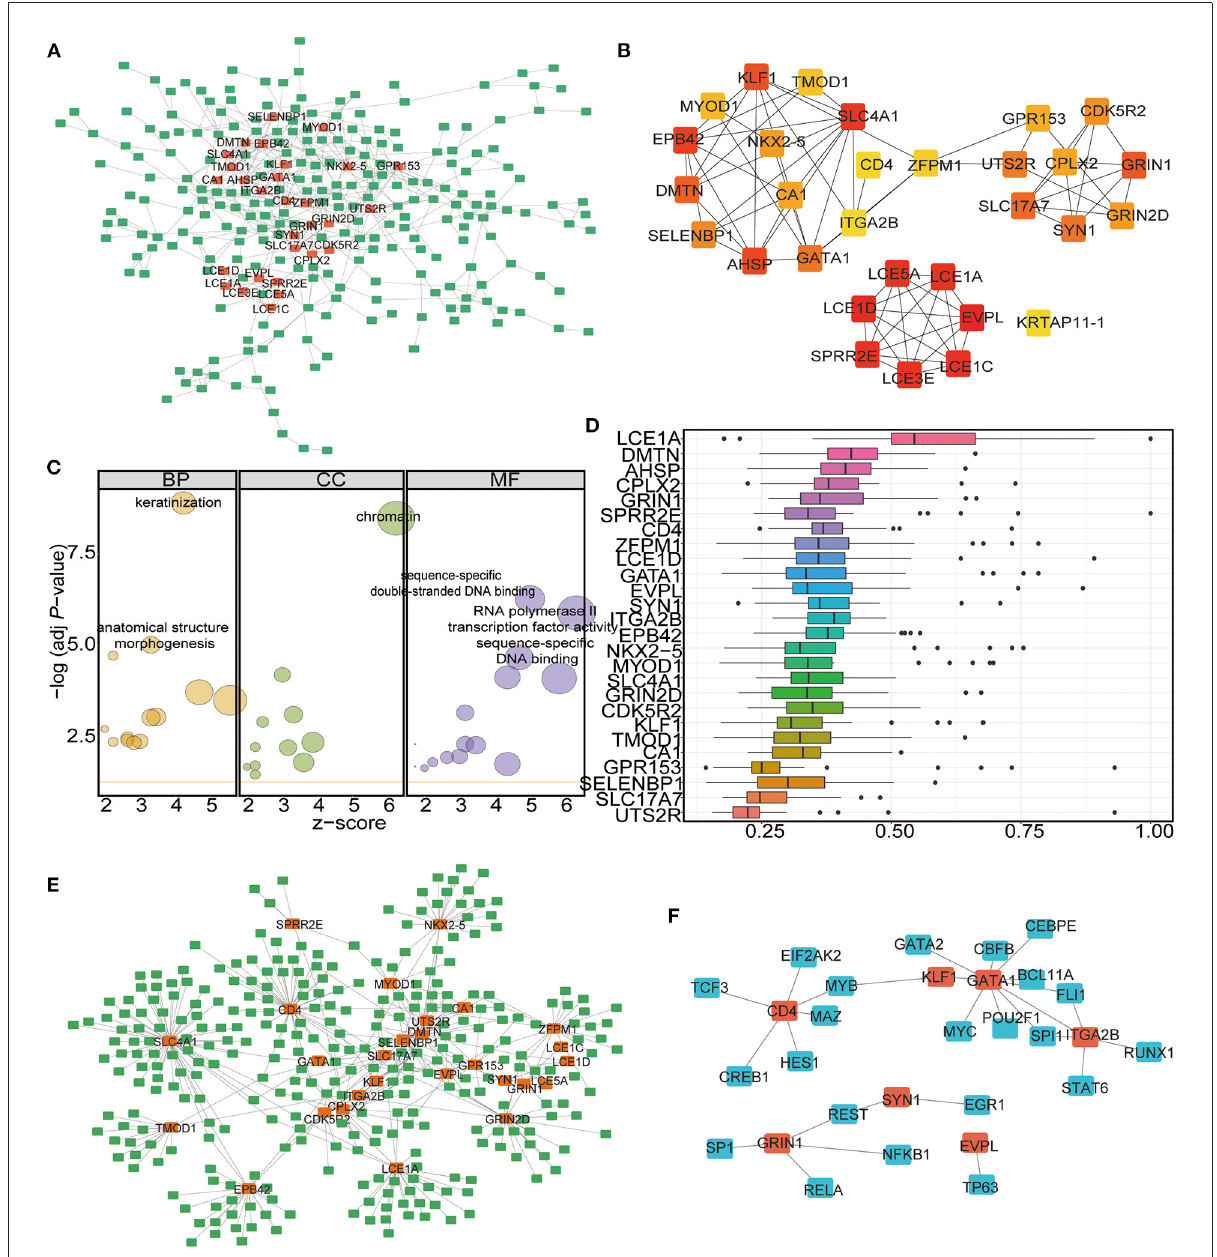
FIGURE7 Identification of the hub-genes and the miRNA-mRNA-TF network construction. (A) PPI network analysis of DEGs in the two clusters. (B) Hub-gene network among the DEGs. (C) GO functional enrichment analysis of the Hub-genes. The node size represents the number of genes contained in the current GO Term. BP: biological process; CC: cellular component; MF: molecular function. (D) Functional similarity analysis of the hub-genes. The horizontal axis is the correlation size, the vertical axis is the gene name. (E) The miRNA-mRNA interaction network of the hub-genes. The green label represents miRNAs, the orange label represents mRNAs. (F) The mRNA-TF interaction network of the hub-genes. The blue label represents TFs, the orange label represents mRNAs.